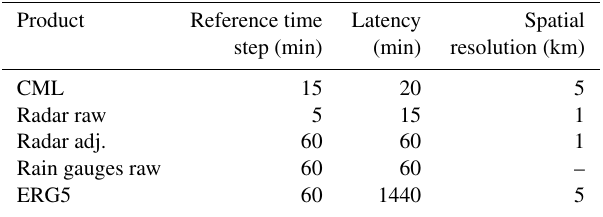
Table 6. Latency and spatial and temporal sampling of the consid- ered precipitation products.